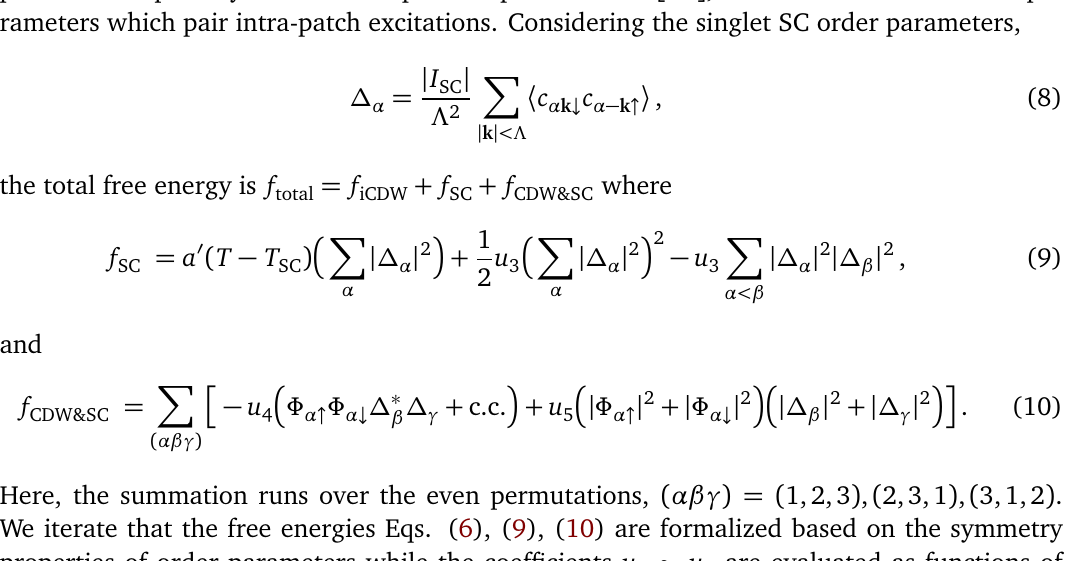
-term in f (Eq. 4 CDW&SC